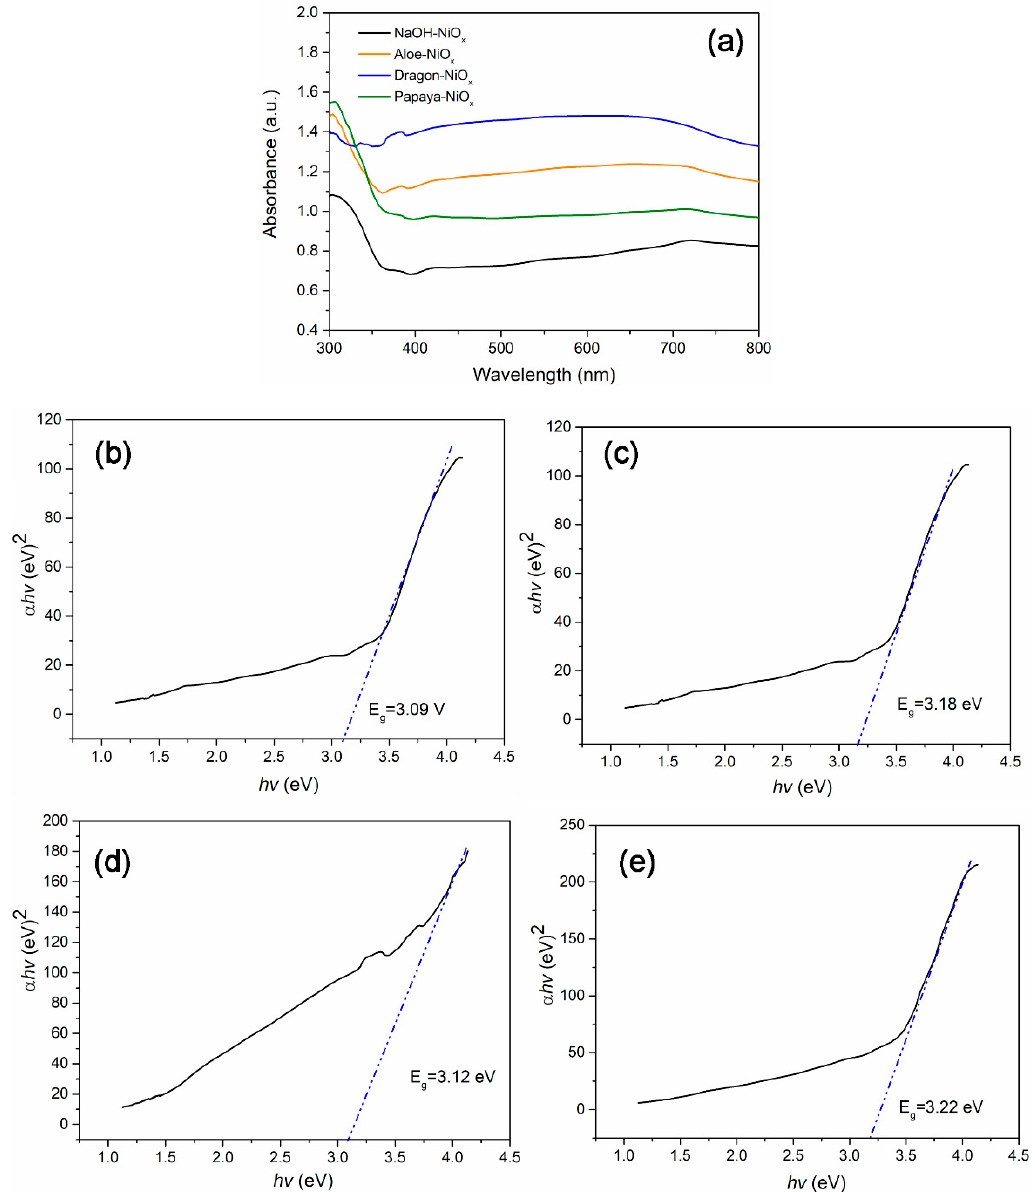
Figure 5. ( a ) UV-Vis absorption spectrum and the corresponding Tauc plot of ( b ) NaOH-, ( c ) aloe-vera-, ( d ) dragon-fruit- and ( e ) papaya-extract-mediated NiO x nanoparticles.